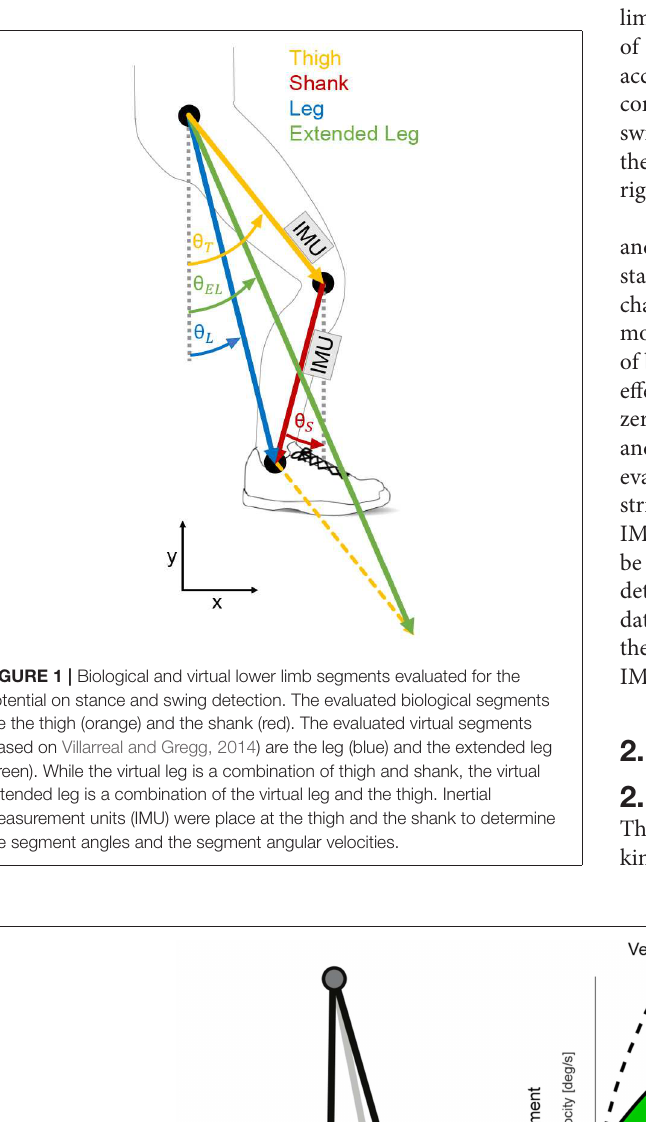
Frontiers in Neurorobotics |